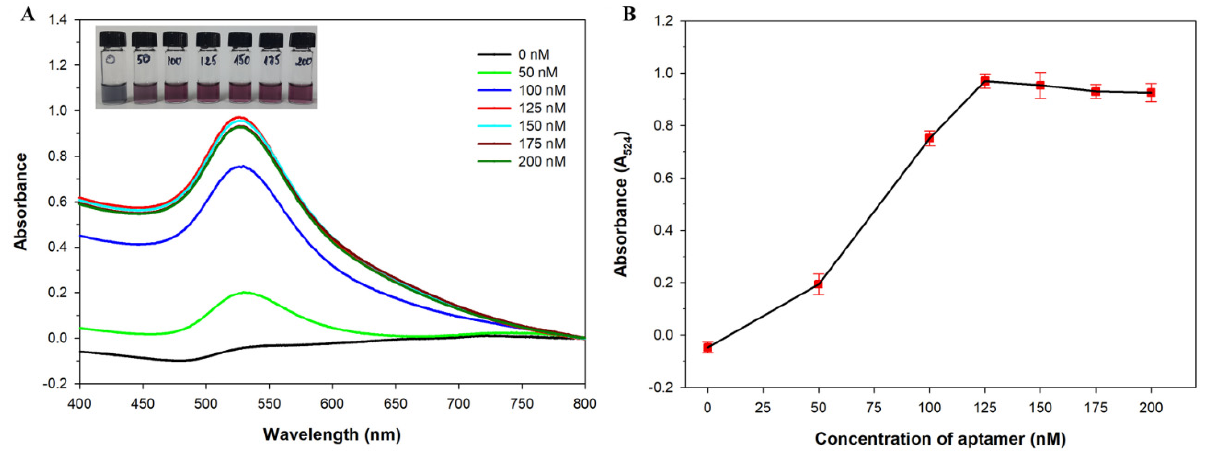
Figure 5. The UV/Vis absorption spectra ( A ) and absorbance intensity changes at 524 nm ( B ) of the gold nanoparticle (AuNP) solutions containing different concentrations of anatoxin-a aptamer after the addition of 40 mM NaCl. Inset: visible color changes of AuNP solutions.